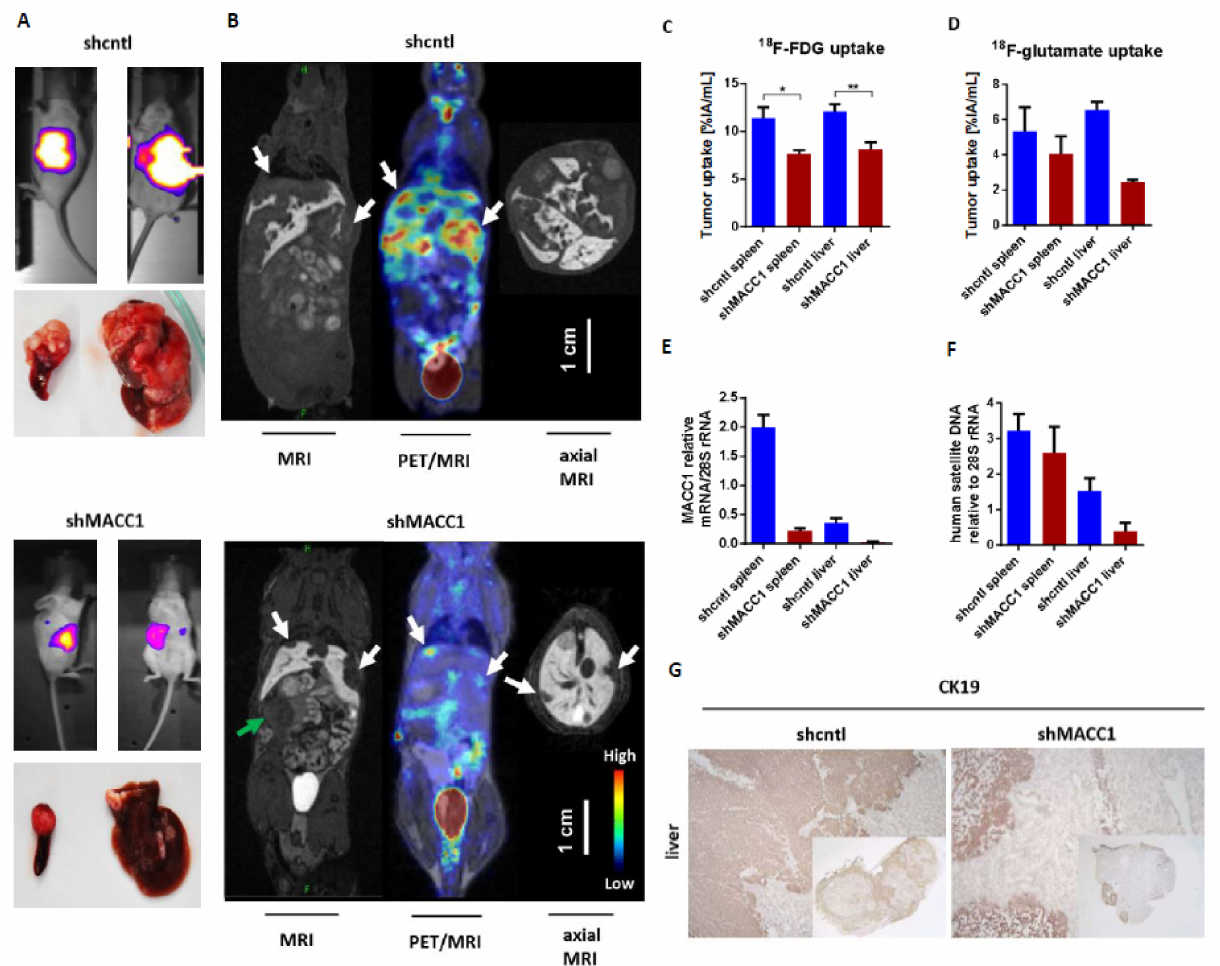
Figure 1. MACC1 enhances 18 F-FDG and 18 F-glutamate uptake in vivo. ( A ) Lateral and ventral bioluminescence imaging of SCID/beige mice 21 days post intrasplenic injection of SW620 shcntl or SW620 shMACC1 cells; transplanted tumor-bearing spleens and liver metastases of these animals are shown. ( B ) PET/MR images of liver metastases (white arrows) 60 min after intravenous injection of 9 MBq or 14 MBq 18 F-FDG in SW620 shcntl or SW620 shMACC1 tumor-bearing SCID/beige mice. T1 GRE EXT 3D coronal MRI shows the metastases with hypointensity, clearly surrounded by normal, vital mouse liver tissue, represented by the hyperintensity of contrast agent Gadolinium™; fused MR and PET image; T1 GRE EXT 3D axial MRI of the liver. The primary tumor in the spleen is indicated by green arrow. In all 3 images scale bar is valid for MRI, PET/MRI and axial MRI. Four mice were imaged in the shcntl group, whereas five mice were imaged in shMACC1 group. ( C ) Quantification of 18 F-FDG and ( D ) of 18 F-glutamate uptake in the primary tumor in the spleen and in liver metastases. Four SW620 shcntl and five SW620 shMACC1 mice were analyzed for 18 F-FDG measurements. Two mice per group were analyzed for 18 F-glutamate measurements. Data represent mean values ± SEM, * p ≤ 0.05, ** p ≤ 0.01. ( E ) MACC1 mRNA expression and ( F ) quantification of human microsatellite DNA in primary tumor (spleen) and liver metastases. Data represent mean values ± SEM. ( G ) CK19-specific immunohistochemistry in cryosections from mouse liver with metastases of SW620 shcntl or SW620 shMACC1 cells. Brown staining indicates human tumor cells with human CK19 expression. Images: 10-fold magnification; inset depicting whole liver tissue: 0.8-fold magnification. CK19: cytokeratin 19. * p ≤ 0.05, ** p ≤ 0.01. Two days after 18 F-FDG imaging we injected 18 F-glutamate intravenously. We